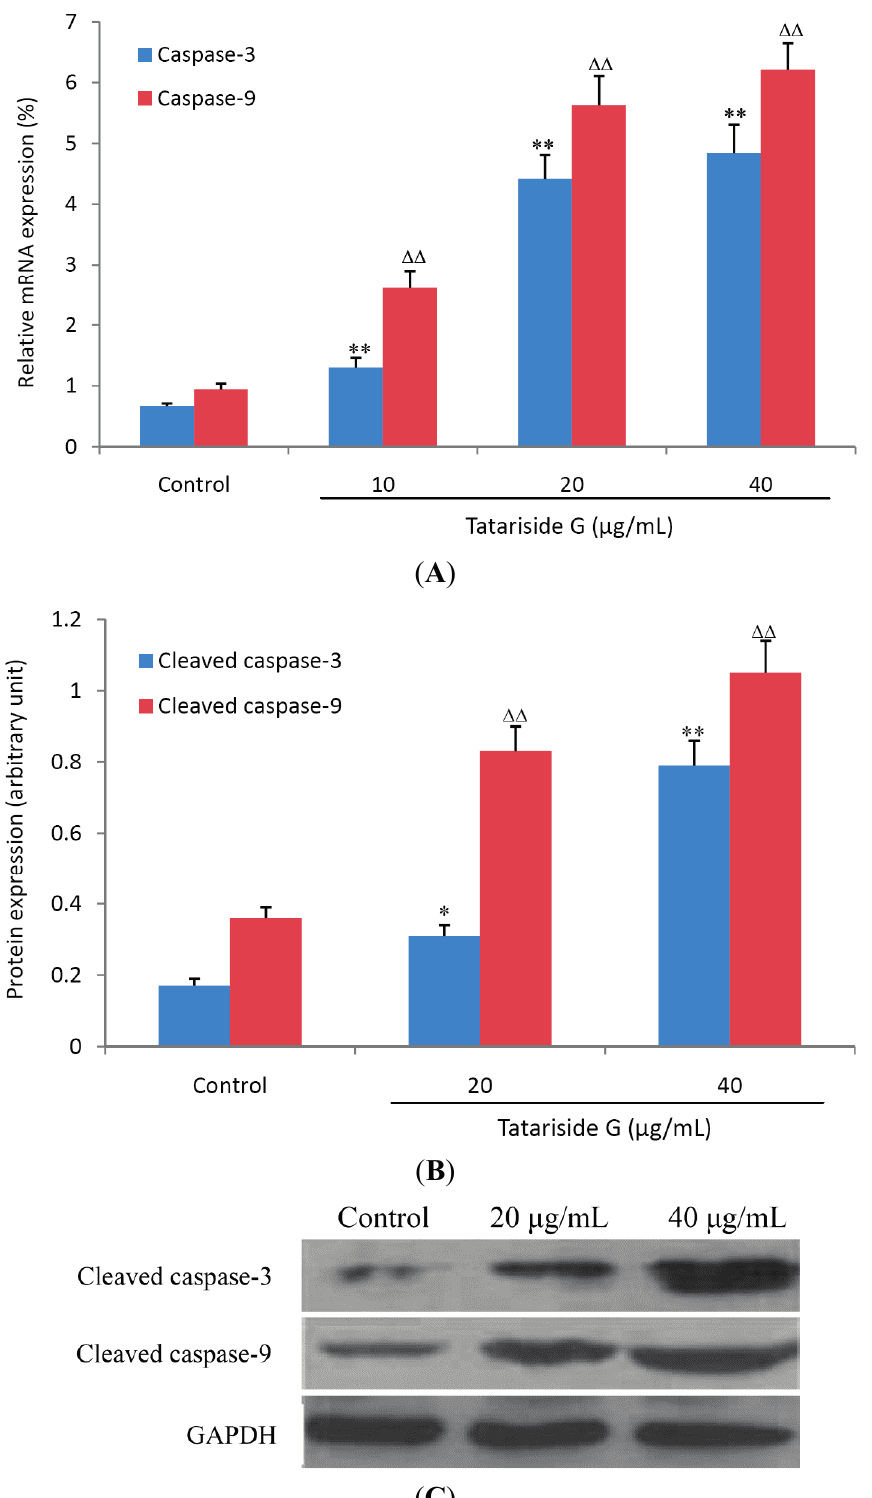
Figure 7. Effects of tatariside G on the mRNA and cleaved protein expression of caspase-9 and caspase-3. After treatment with tatariside G (10, 20, and 40 μ g/mL) for 6 h or 12 h, the mRNA ( A ) and cleaved protein ( B ) expression of caspase-9 and caspase-3 was analyzed by FQ-RT-PCR or western blot. ( C ) Representative western blot picture of HeLa cells treated with tatariside G for 12 h. GAPDH was used as loading control. **, ΔΔ p < 0.01 vs. the control group. Data are expressed as the mean ± SD. n = 6 ( A ) or 3 ( B